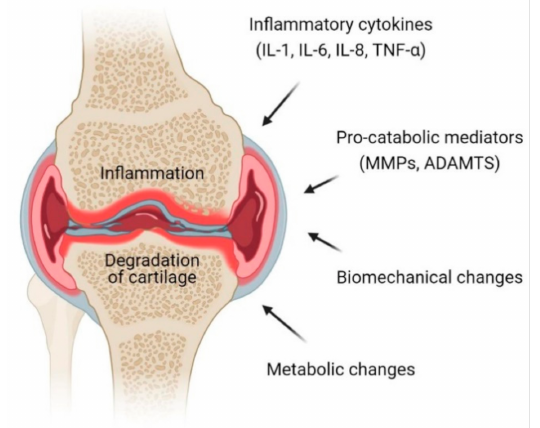
Figure 1. Pathophysiology of osteoarthritis (OA) at the knee joint. Inflammation and degradation of cartilage at the joint are common features of OA which resulted from the release of proinflammatory cytokines including interleukin (IL)-1, IL-6, IL-8 and TNF- α , pro-catabolic mediators such as matrix metalloproteinases (MMPs) and a disintegrin and metalloproteinase with thrombospondin motifs (ADAMTS), biomechanical changes and metabolic